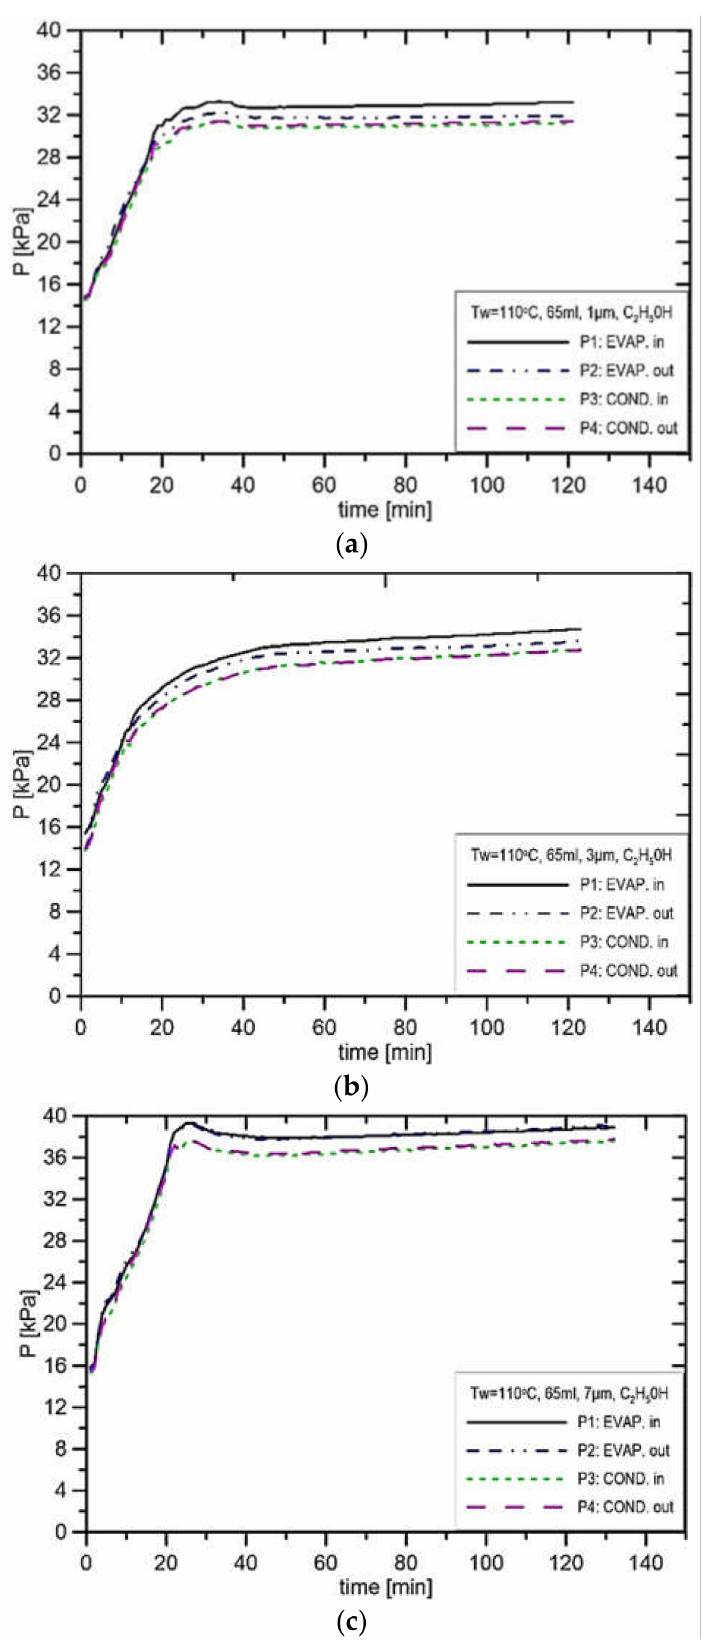
Figure 15. Distribution of pressure in function of time when using ethanol, charge volume 65